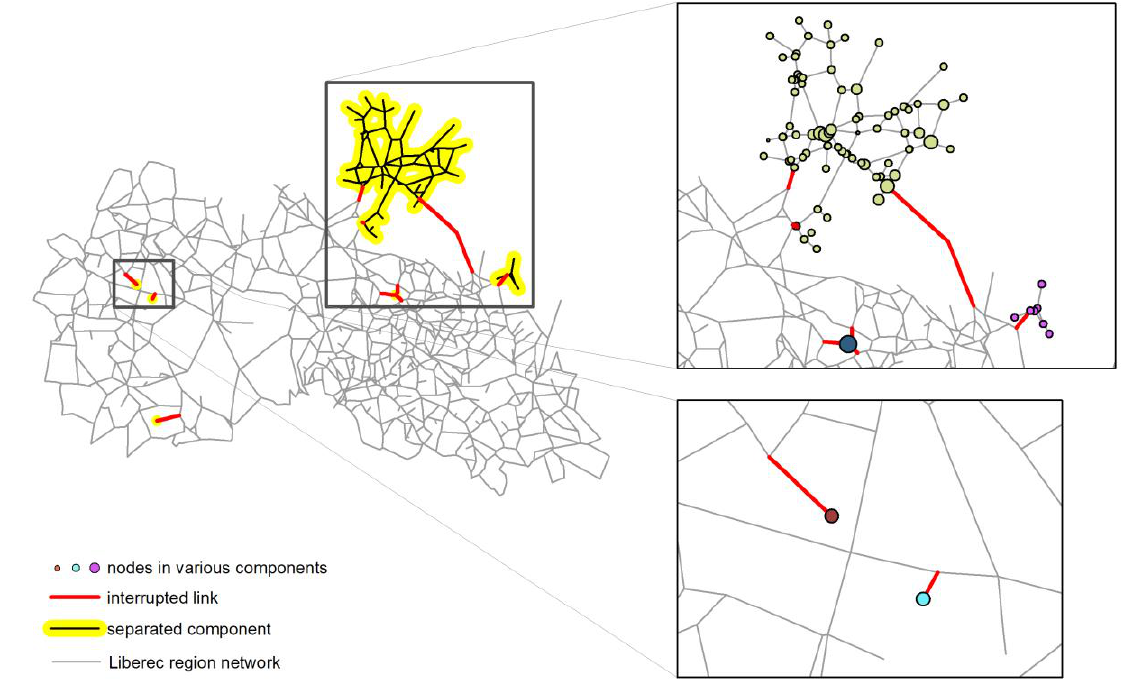
Figure 11. The worst scenario found by ANSA for ten concurrently interrupted road links in the Liberec region network. 41,877 people (9.72%) cut off from the main network.